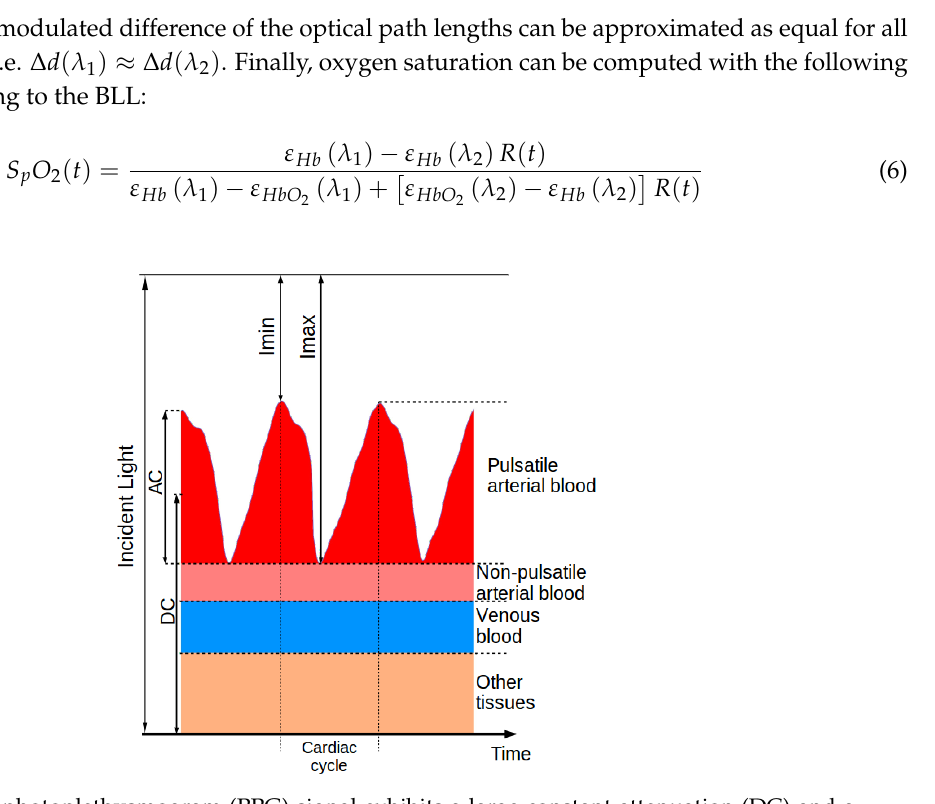
Figure 1. The photoplethysmogram (PPG) signal exhibits a large constant attenuation (DC) and a variable portion (AC) due to the heart rate modulation